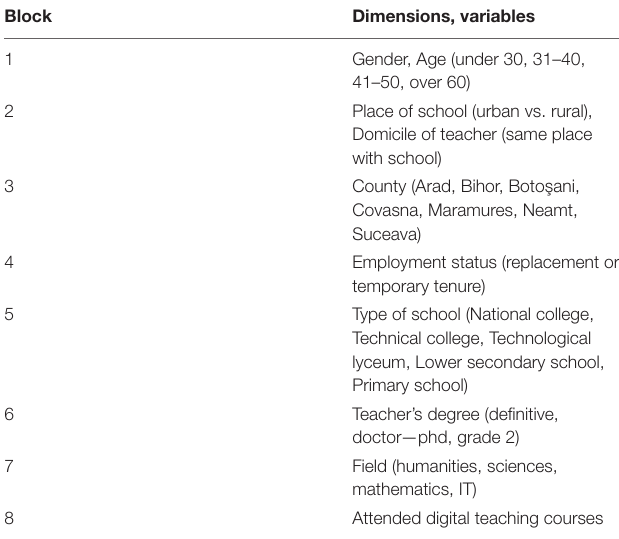
TABLE 2 | The sequence of variables included in hierarchical linear modeling. Block